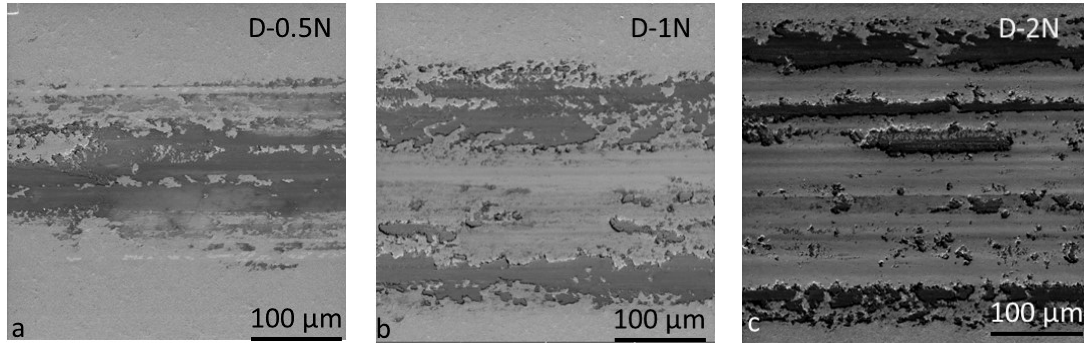
Figure 8. SEM wear track image at dry condition for: ( a ) 0.5 N; ( b ) 1 N; and ( c ) 2 N.